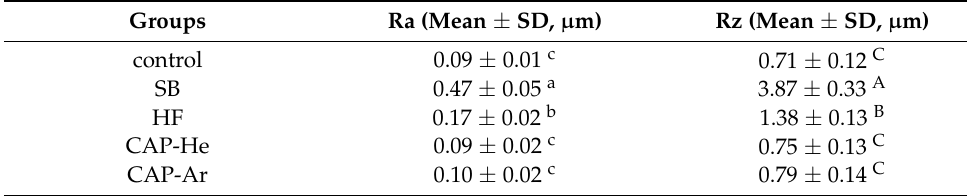
Table 3. Surface roughness of RNC